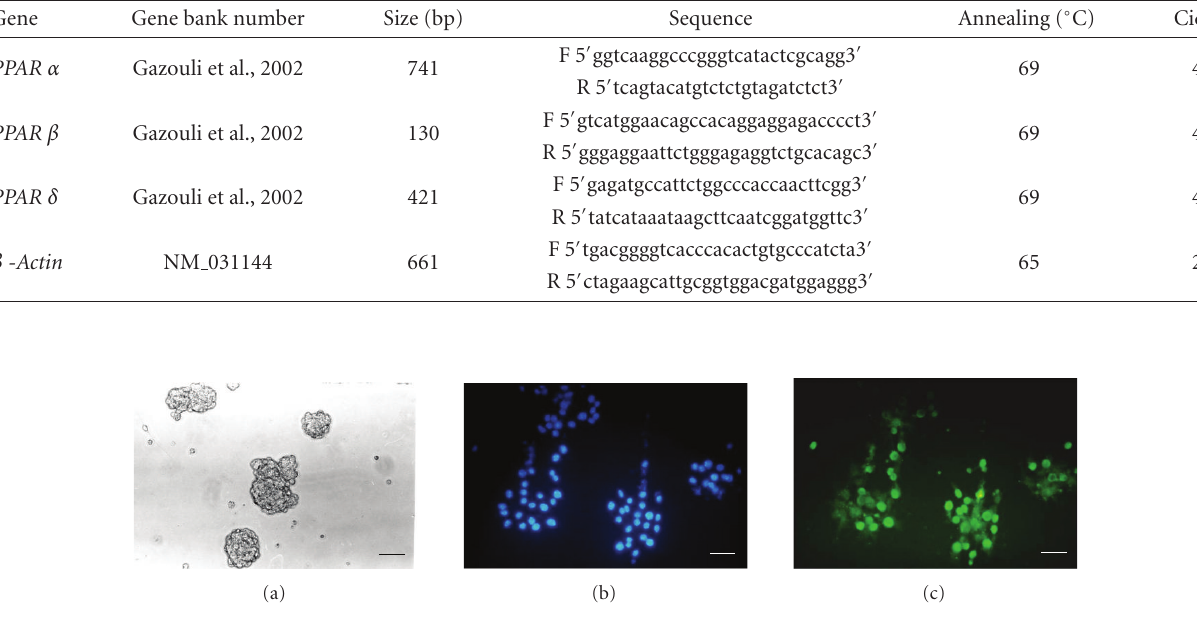
Figure 1: Contrast phase microscopy of neural stem cells growing in neurospheres (a). In (c), BrdU incorporation is shown. Hoechst nuclear staining of the same field is shown in (b). Bar = 40 μ